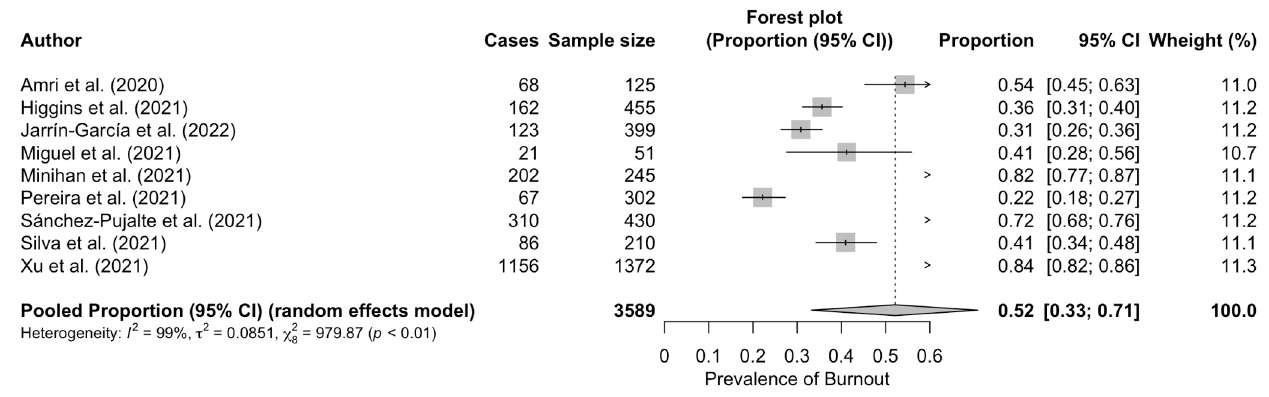
Figure 2. Forest plot for the prevalence of burnout among teachers [40–48].